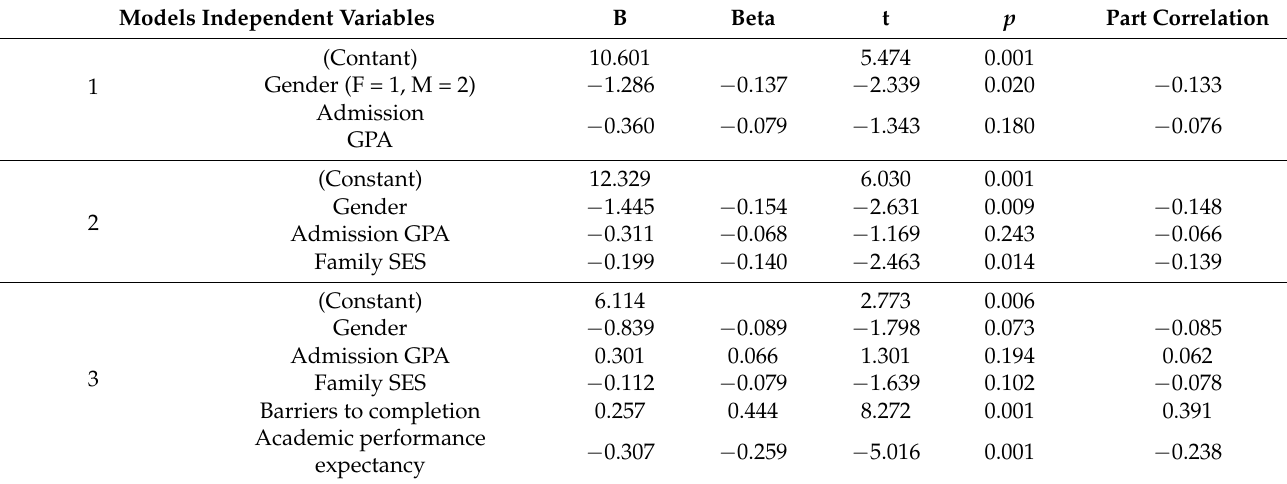
Table 7. Variables that explain dropout intention using hierarchical multiple regression (H7) ( * ) . Models Independent